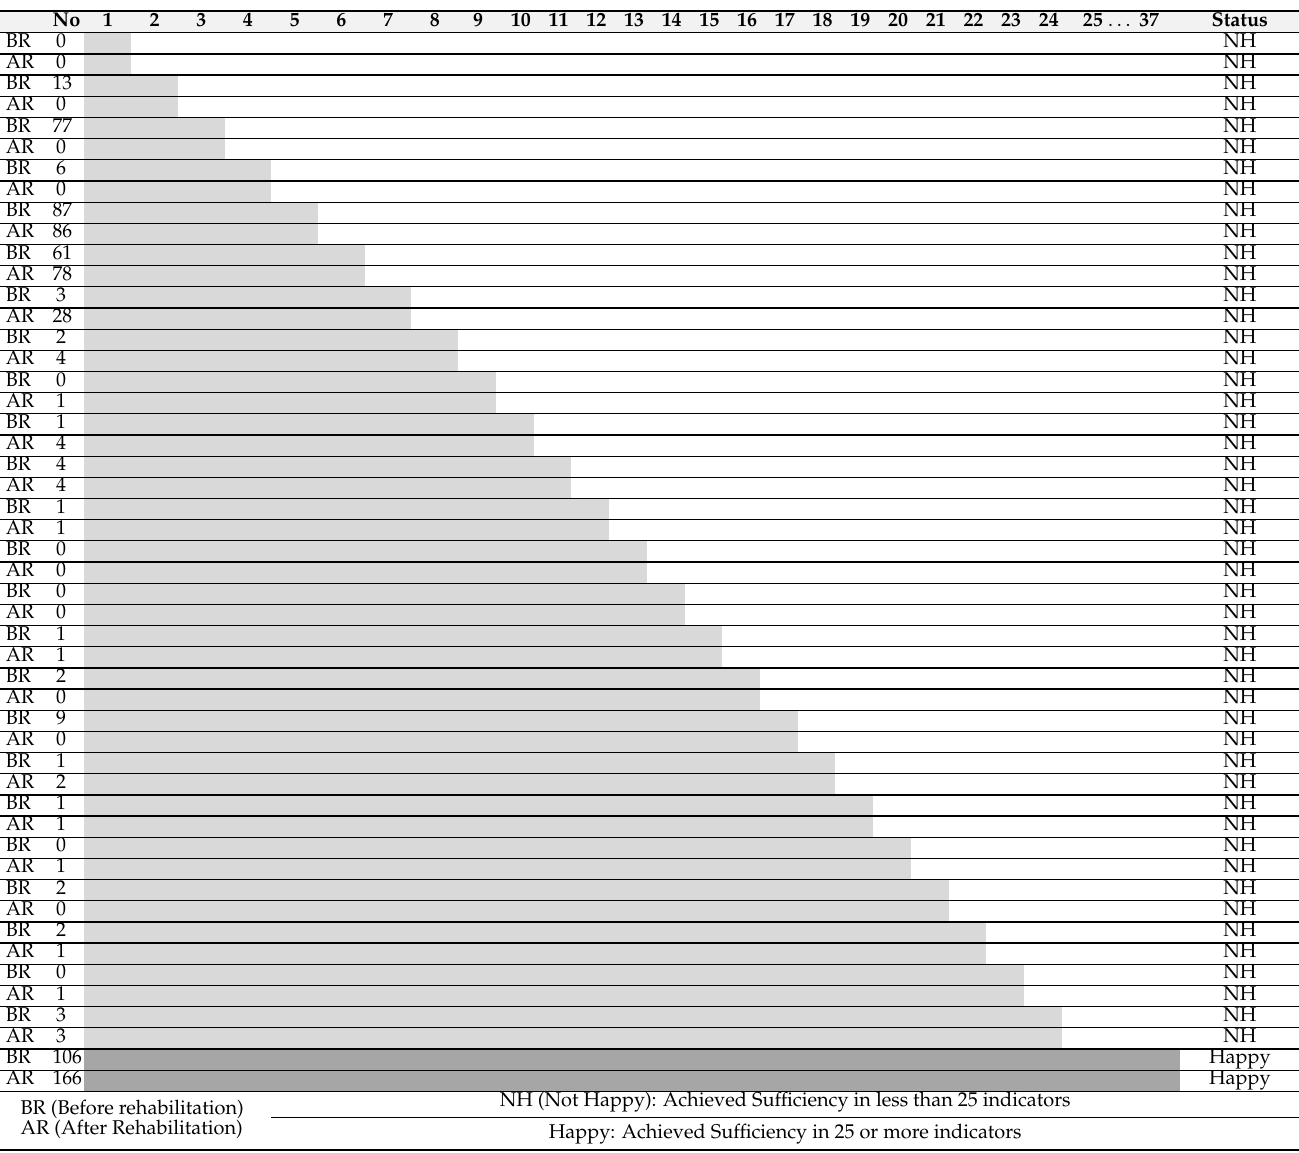
Table 3. Sufficiency of the happy and not happy people. Source: Compiled by the researchers. No